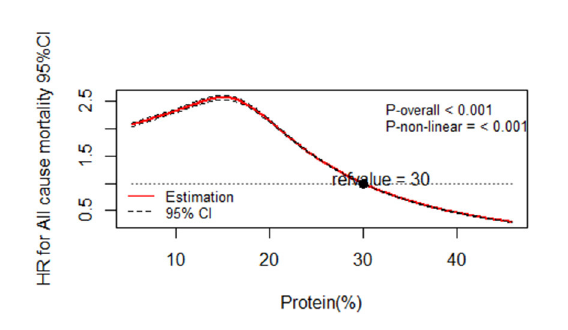
FIGURE1 Dose-response relationship of protein-to-carbohydrate percentage energy ratio z -score with all-cause mortality. Multivariable-adjusted restricted cubic spline analysis for the continuous association of %E P:C and all-cause mortality. Covariables are listed in the Table 5 footnotes (model 3). The y- axis shows the HRs for all-cause mortality for any %E P:C intake z -score, compared with the reference value set at an intake of 1.62. The black dot line indicates the 95% CIs.